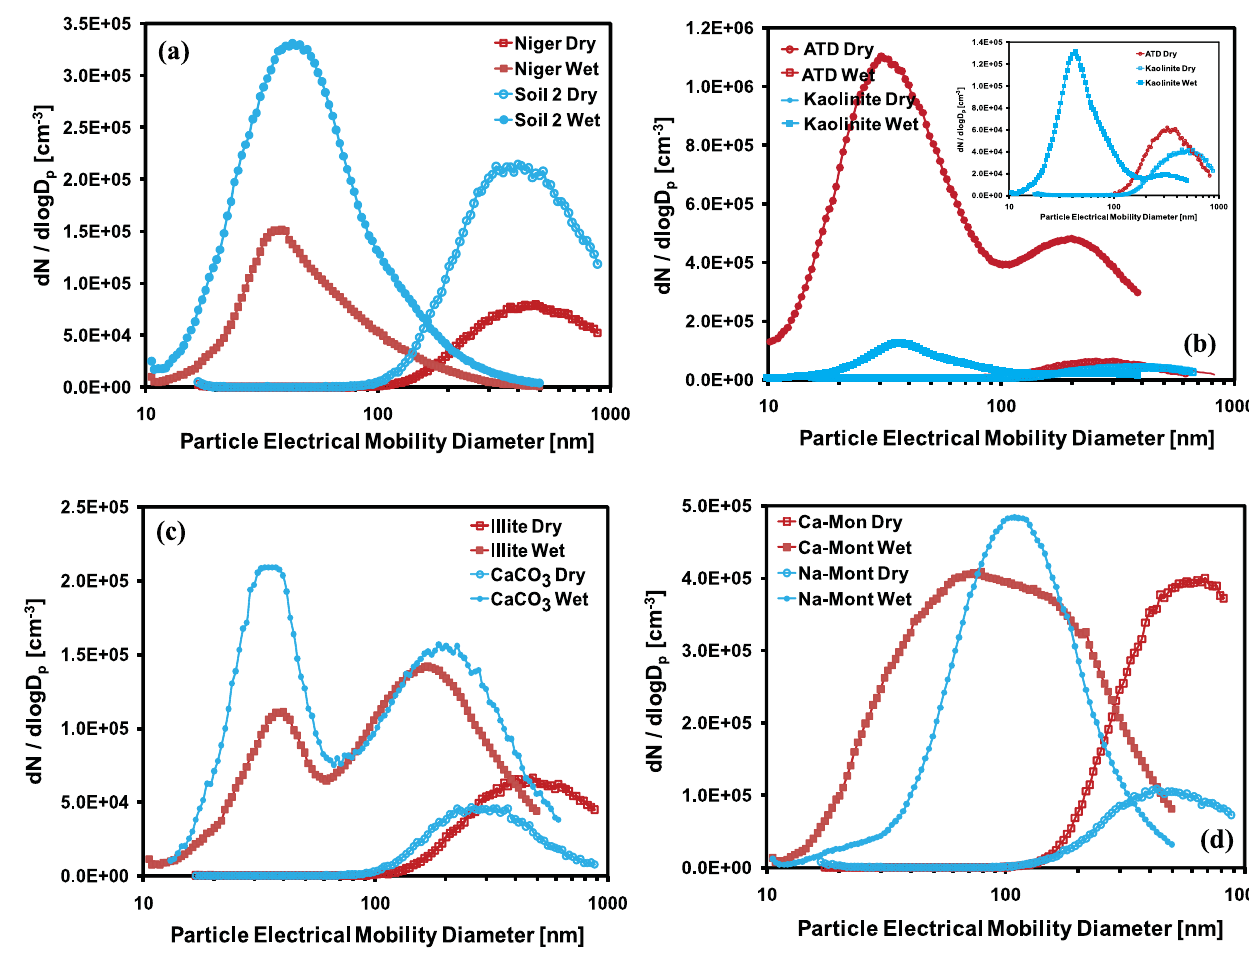
Fig. 1. Particle number size distribution measured by the SMPS system via dry generated and wet generated techniques for (a) Niger Soil and East Asian Soil 2, (b) ATD and Kaolinite, (c) Illite and CaCO 3 and (d) Montmorillonite (Na-rich and